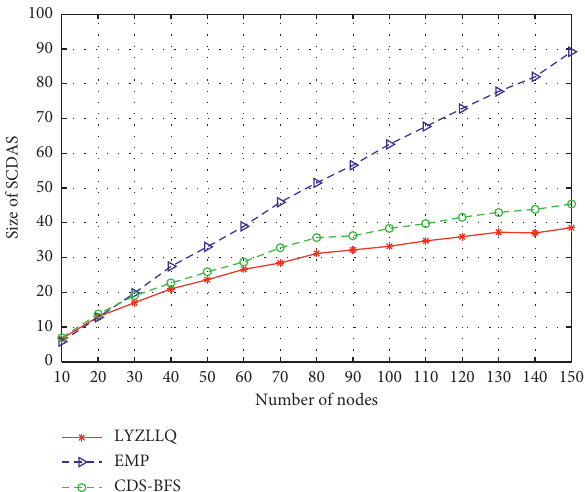
Figure 8: Impact of the number of nodes on the performance of the